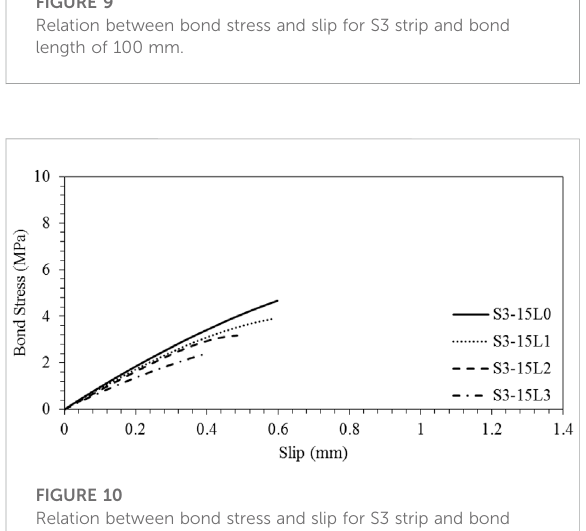
FIGURE 10 Relation between bond stress and slip for S3 strip and bond length of 150